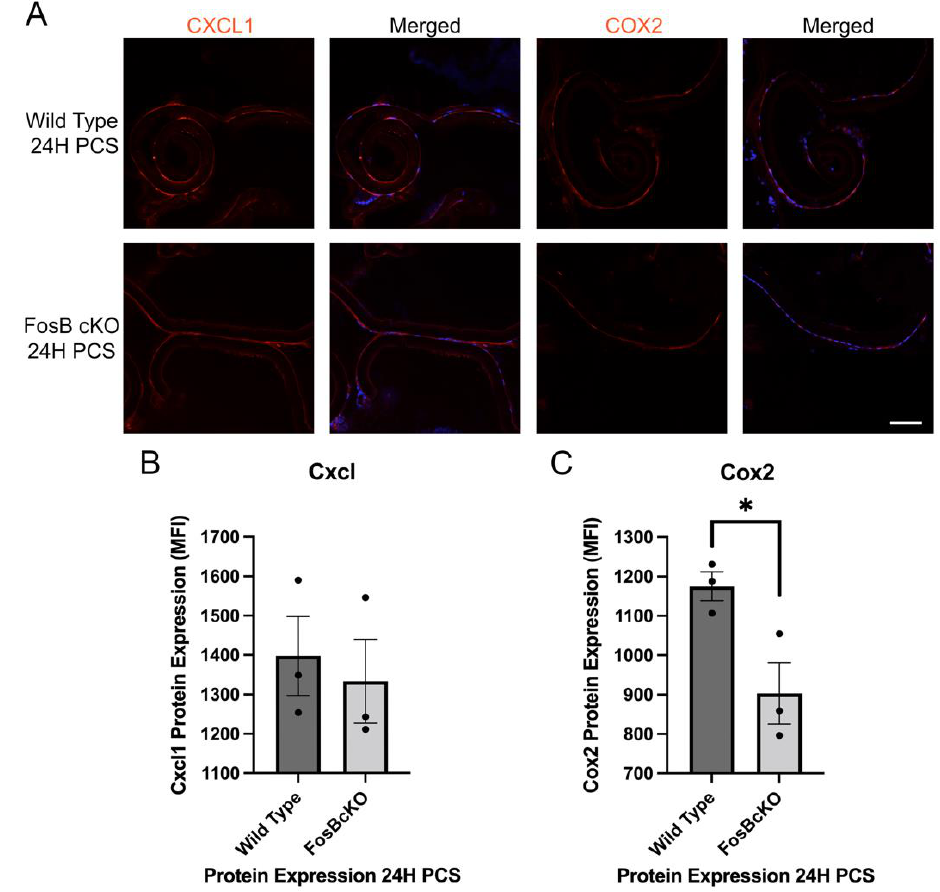
Figure 9. Inflammatory mediator protein expression in FosBcKO LECs compared to Wild Type at 24 h PCS. ( A ) Immunofluorescent staining for the proinflammatory mediators Cxcl1 and Cox2 (red) at 24 h PCS. Blue is DNA and Scale bar = 70 µ m. ( B ) Quantification of Cxcl1 levels in LECs at 24 h PCS by immunofluorescence p = 0.97. ( C ) Quantification of Cox2 levels in LECs at 24 H PCS by immunofluorescence * represents p -value ≤ 0.01. The black dots in B & C represent the individual biological replicates for each bar in the bar graph.